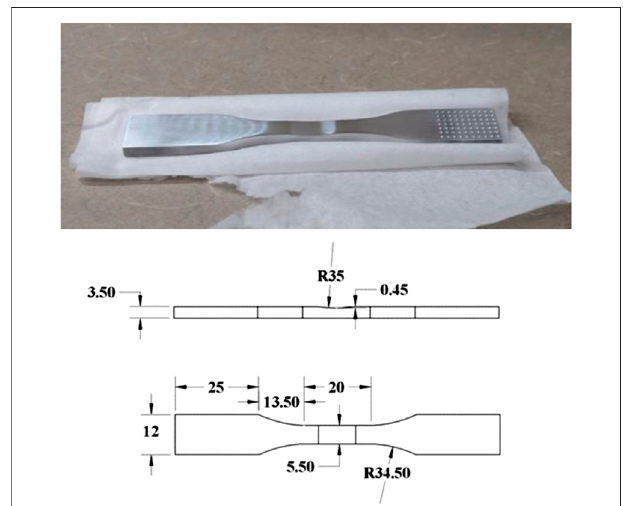
FIGURE 1 | (A) Flat tensile specimen with shallow notch used for fatigue testing. (B) Specimen dimensions